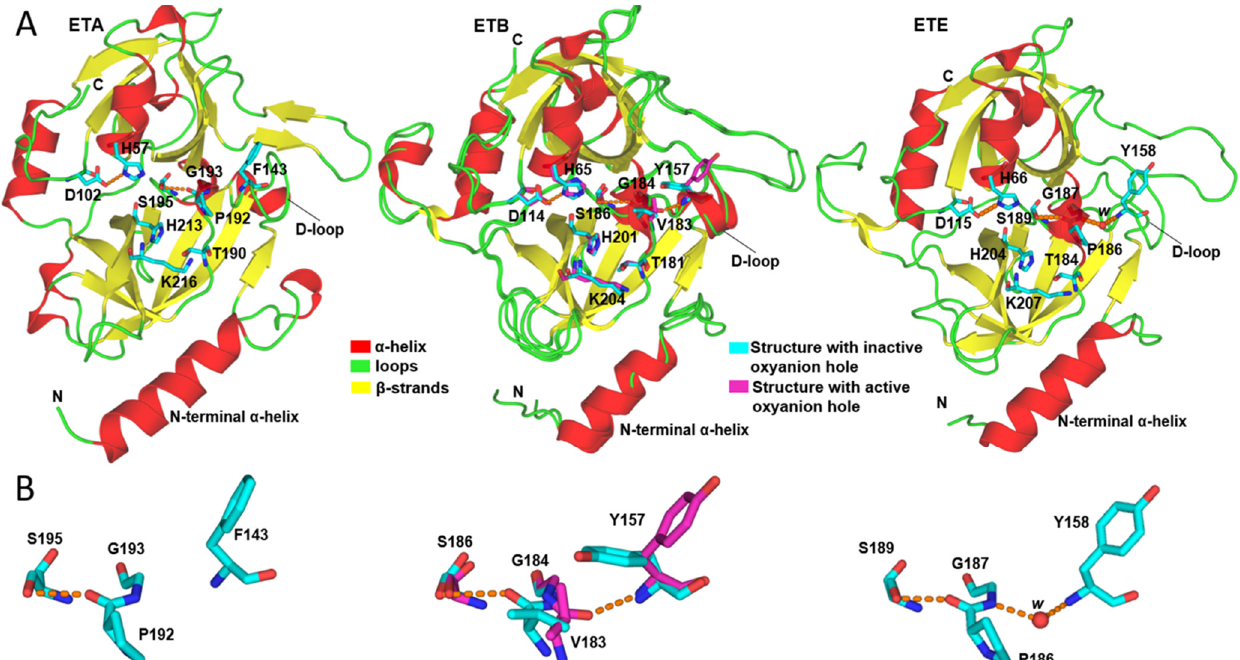
Figure 1. Structural representations of S. aureus ETs. ( A ) Cartoon and stick representations of the backbones and key active site residues of ETA (PDB: 1EXF), ETB (PDBs: 1DT2, magenta sticks, and 1QTF, cyan sticks) and ETE (PDB: 5C2Z), respectively. The main structural features of these proteins are depicted, i.e., the D102/114/115-H75/65/66-S195/186/189 catalytic triad, the N-terminal α -helix, the presence in the S1 pocket of residues T190/181/184, H213/201/204 and K216/204/207, which are crucial to the specificity for Glu-P1, atypical flipped conformation of P192/V183/P186(O) atom and the D-loop, which is believed to control the flip. ( B ) Stick representations of the alternate P192/V183/P186(O) conformations observed in the available crystal structures of ETA, ETB and ETE. In all cases, the orange dashed lines represent H-bonds. Residues of ETA are labeled according to the chymotrypsin numbering for ETA, as in PDB: 1EXF. Since the available PDBs of ETB and ETE do not follow the chymotrypsin numbering, residues of these toxins are labeled in sequential order. Numerical labels separated by / correspond to the positions of equivalent residues in ETA, ETB and ETE sequences, in that order. Of note, a water molecule, labeled w , forms a water bridge (red sphere) between G187(N) and Y158(N) in the crystal structure of ETE (PDB: 5C2Z). The actual residue numbers in the structure 5C2Z ( n ) took into account 30 residues of the signal peptide and are different from those used in this work ( n-